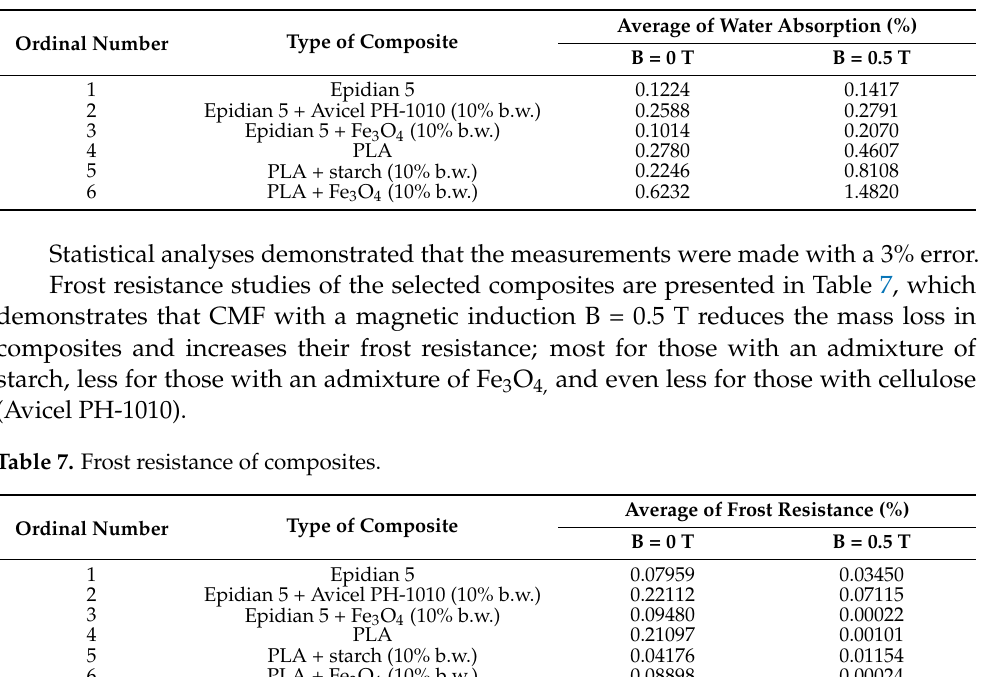
Table 6. Absorptivity of composites.